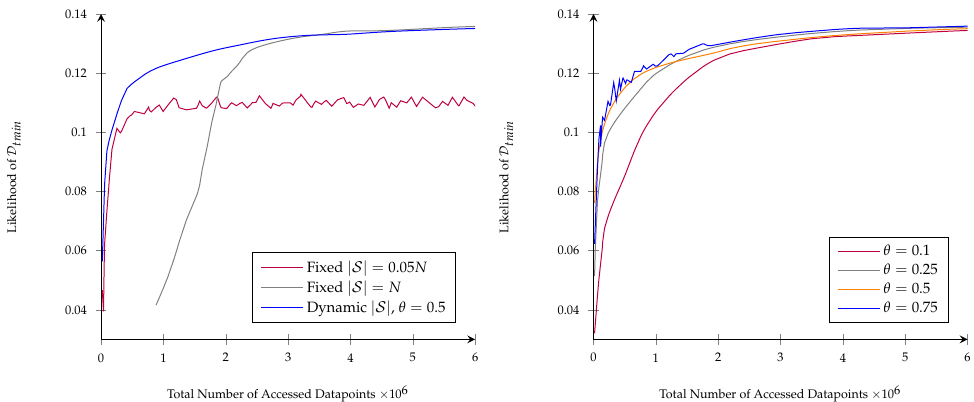
Figure 11. Results on a multi-class logistic regression task using NCG. ( Left ) Comparison of dynamic subsample size selection with fixed sample sizes. ( Right ) Comparison of different values for θ